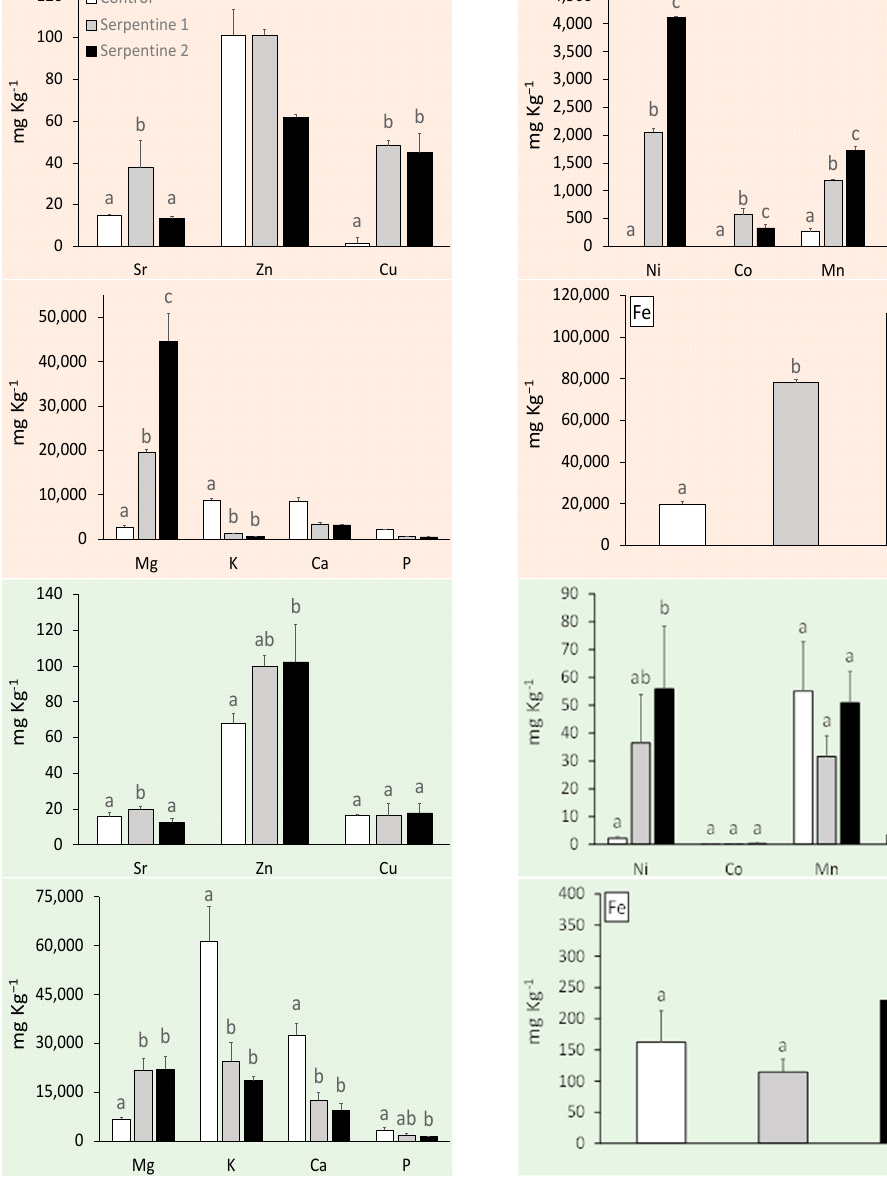
Figure 1. Trace metals and macronutrient concentrations (mean ± std) in soil (orange) and B. radula leaves (green) under the study treatments. Different letters indicate significant treatment differences (Tukey, p < 0.05). Table 1. Principal component analysis results are based on the heavy metals for the soil